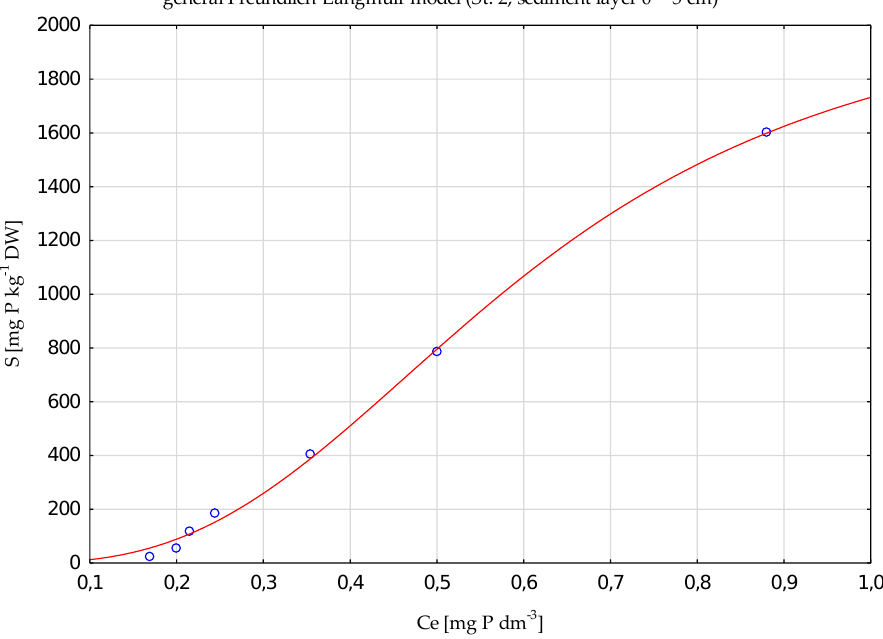
Figure 9. Examples of modeled P adsorption isotherms fitting to experimental P adsorption data. Table 3. P adsorption characteristics of bottom sediment of Lake Kortowskie at St. 1 (control).